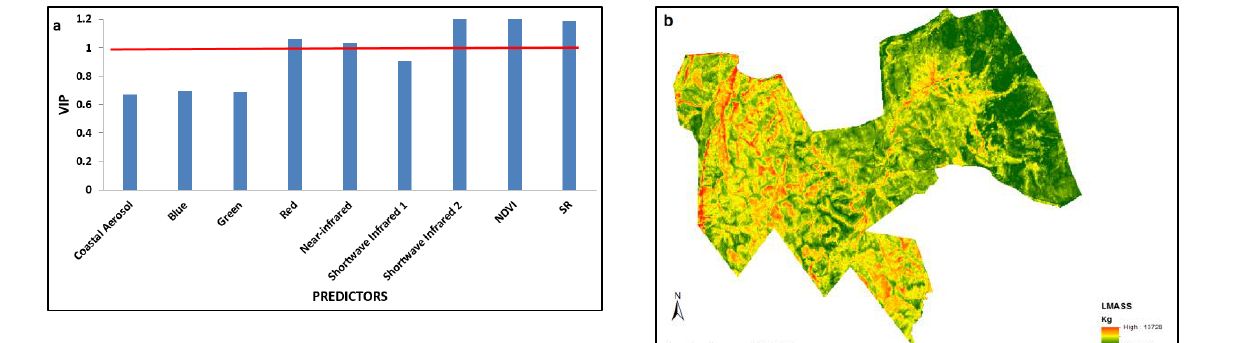
Figure 3. (a) VIP variables for TE. The red line indicates the VIP cut off value of 1. All predictors above the red line are significant in the model